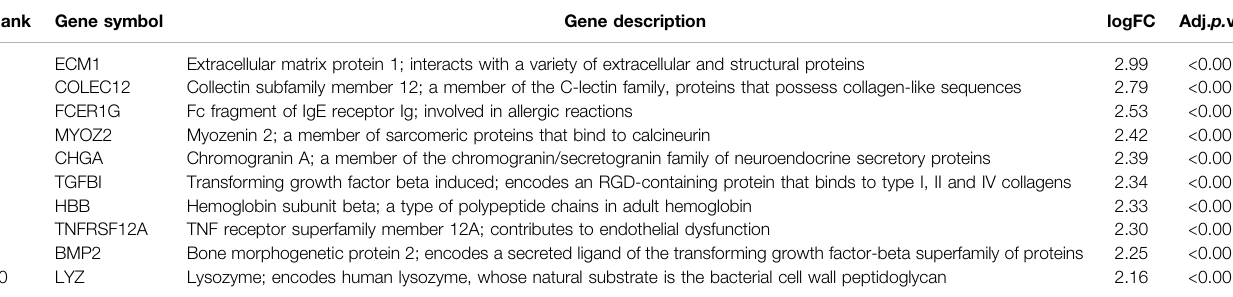
TABLE 1 | Top 10 up-regulation differentially expressed genes in MN group. Rank Gene symbol